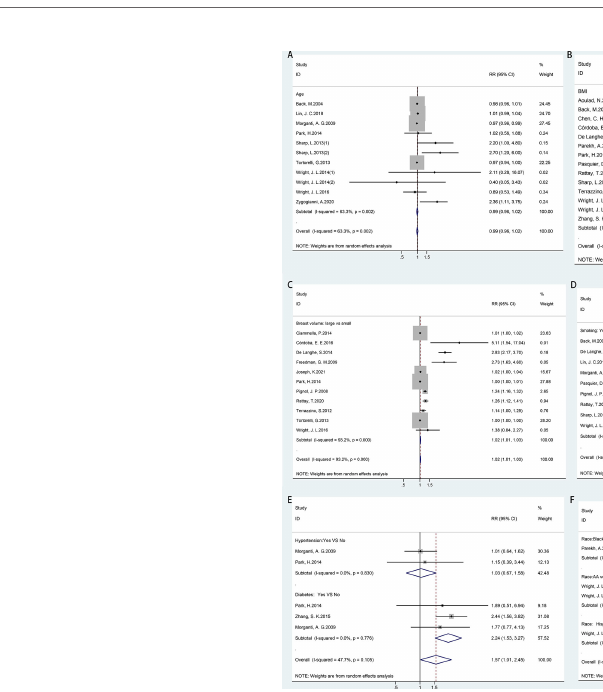
FIGURE 2 | Forest plot of studies among patient-related risk factors associated with acute radiation dermatitis. (A) Age. (B) Body mass index (BMI). (C) Breast volume. (D) Smoking. (E) Chronic disease (hypertension/diabetes). (F)